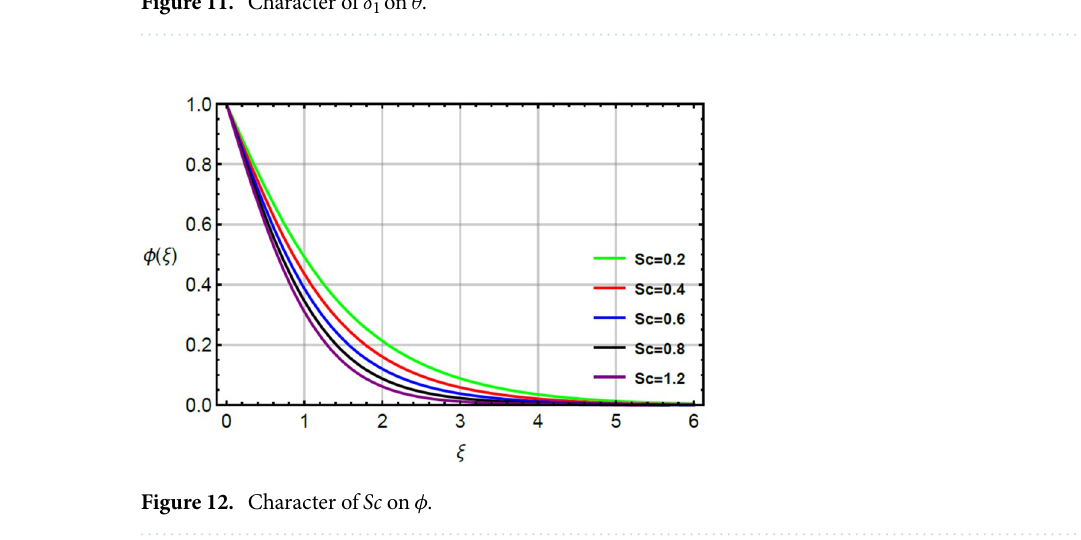
Figure 11. Character of δ 1 on θ .